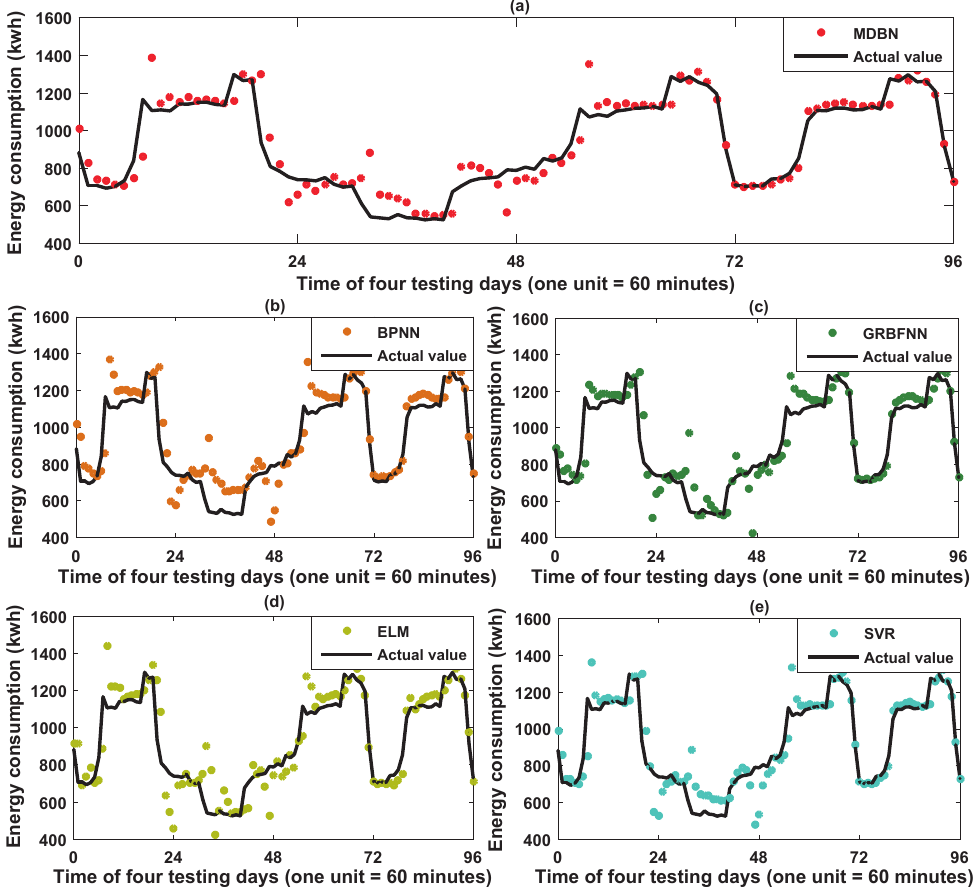
Figure 9. Parts of prediction results of the five predictors constructed by utilizing the energy-consuming pattern: ( a ) hybrid DBN model; ( b ) BPNN; ( c ) GRBFNN; ( d ) ELM; and ( e )